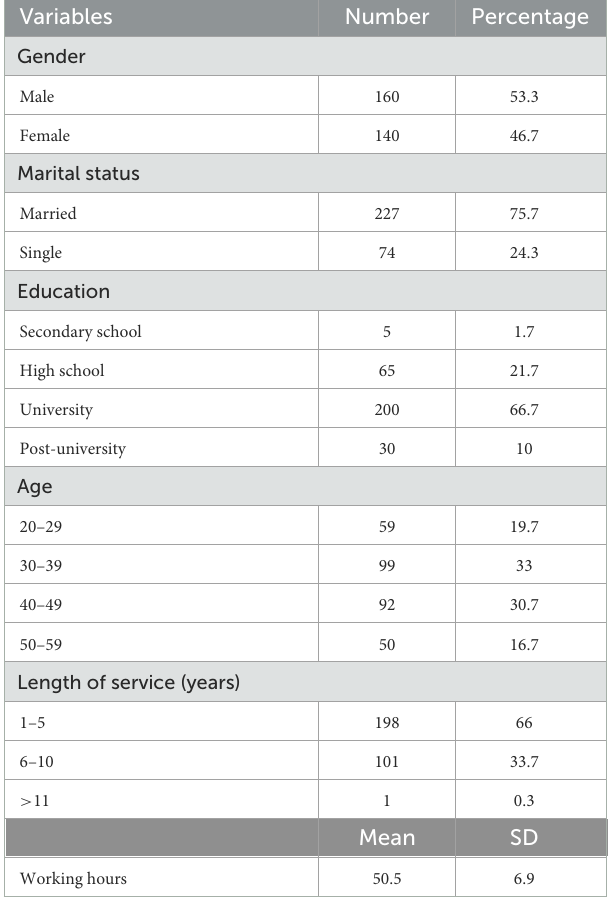
TABLE 1 Demographic characteristics of the